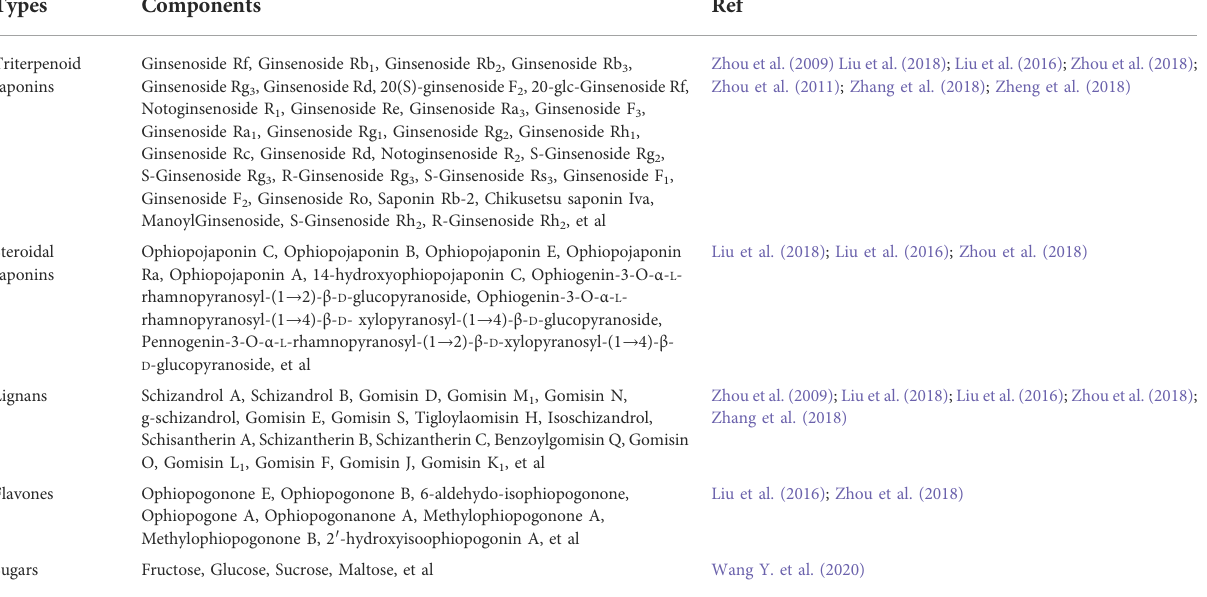
TABLE 1 Chemical components of YiQiFuMai